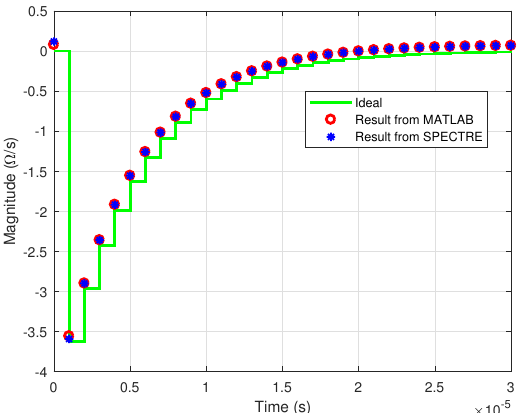
Figure 15. Theoretical time-based EIS (green curve) compared with simulation results from MATLAB (red points) and SPECTRE (blue points) implementations, respectively.